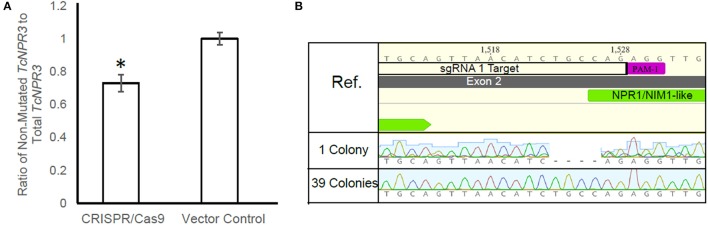
Quantification of gene editing frequency. (A) qPCR measurement of the ratio of TcNPR3 lacking a deletion to total TcNPR3. Bars represent means calculated from eight replicates, error bars are standard error from eight replicates. Asterisk denotes t-test p < 0.05. (B) Alignment of electropherograms derived from cloning and sequencing the upper band of TcNPR3 target region PCR product from a CRISPR/Cas9-transformed cacao leaf. Ref. is TcNPR3 sequence from the Criollo genome browser (Argout et al., 2011).